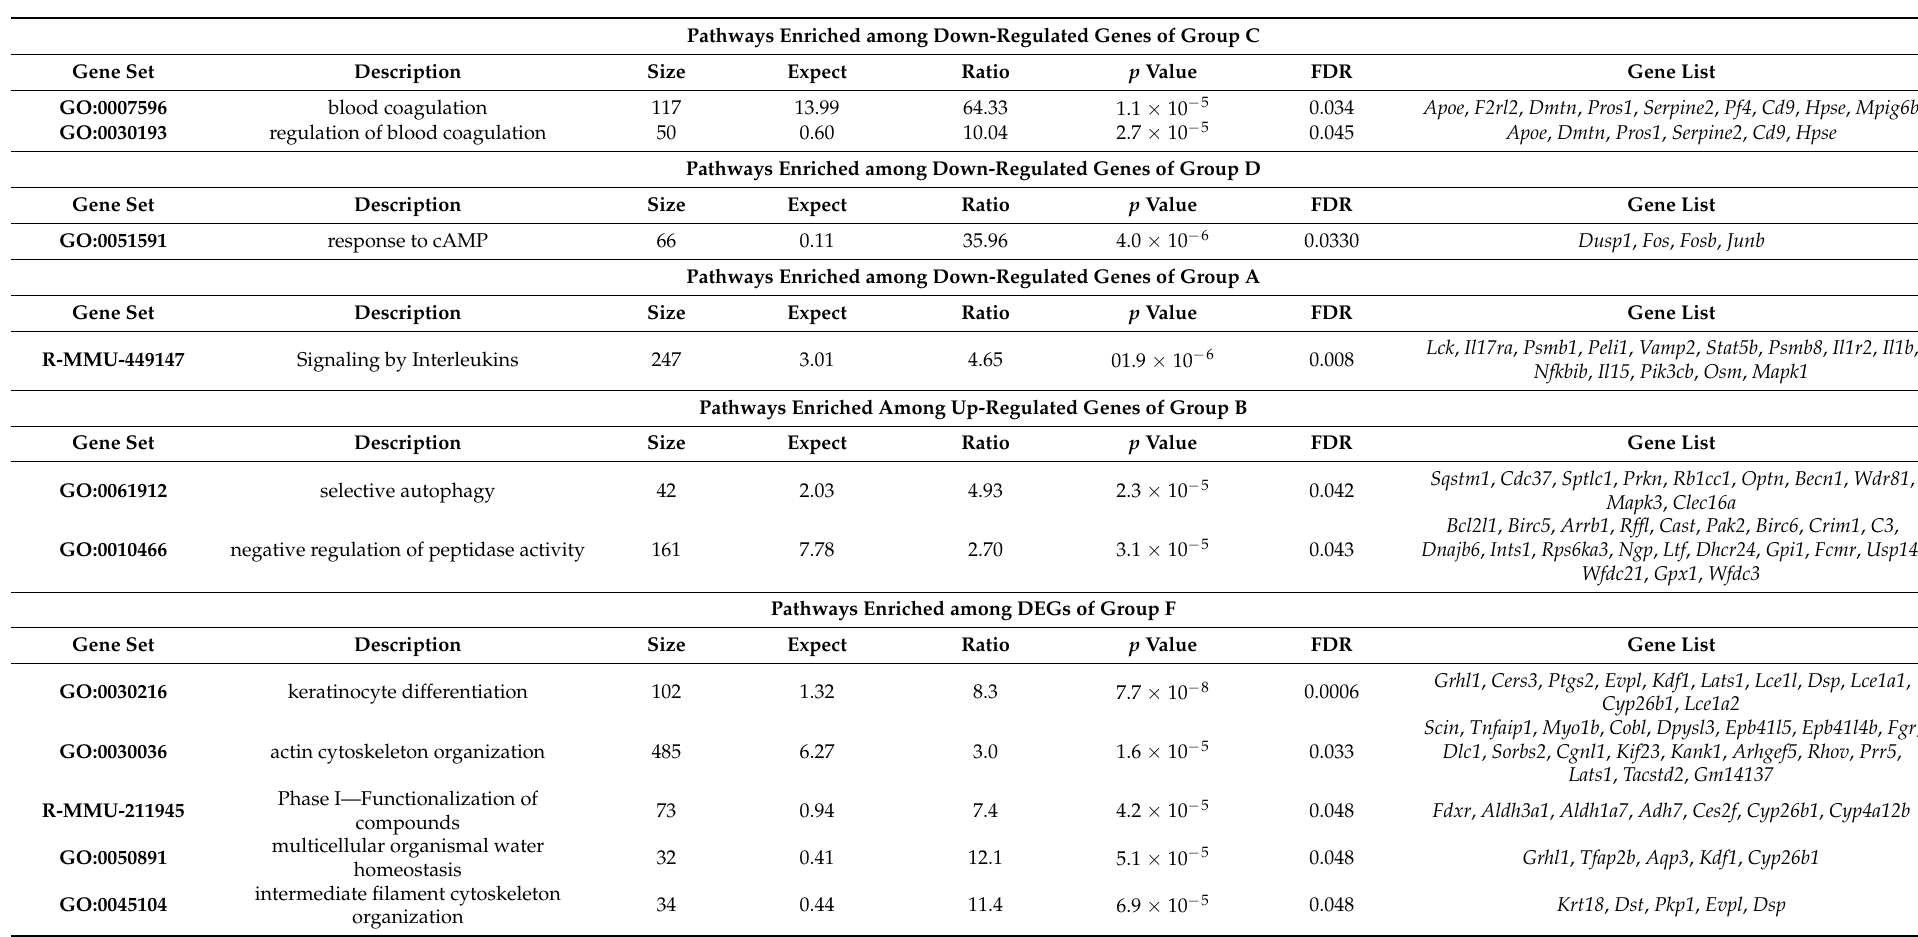
Table 3. ORA results for the groups derived from Venn